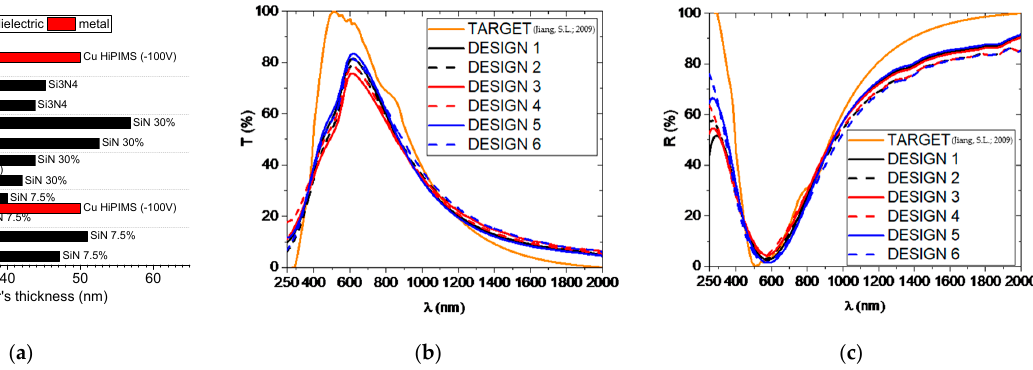
Figure 11. Theoretical designs ( a ) characterized by specific T ( b ) and R ( c ) spectra for different dielectric–metal combinations [29].